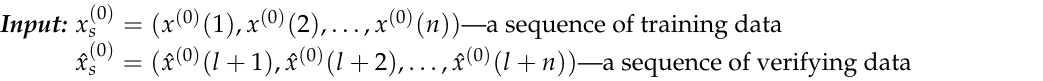
Algorithm 2: Pseudo Code of the genetic